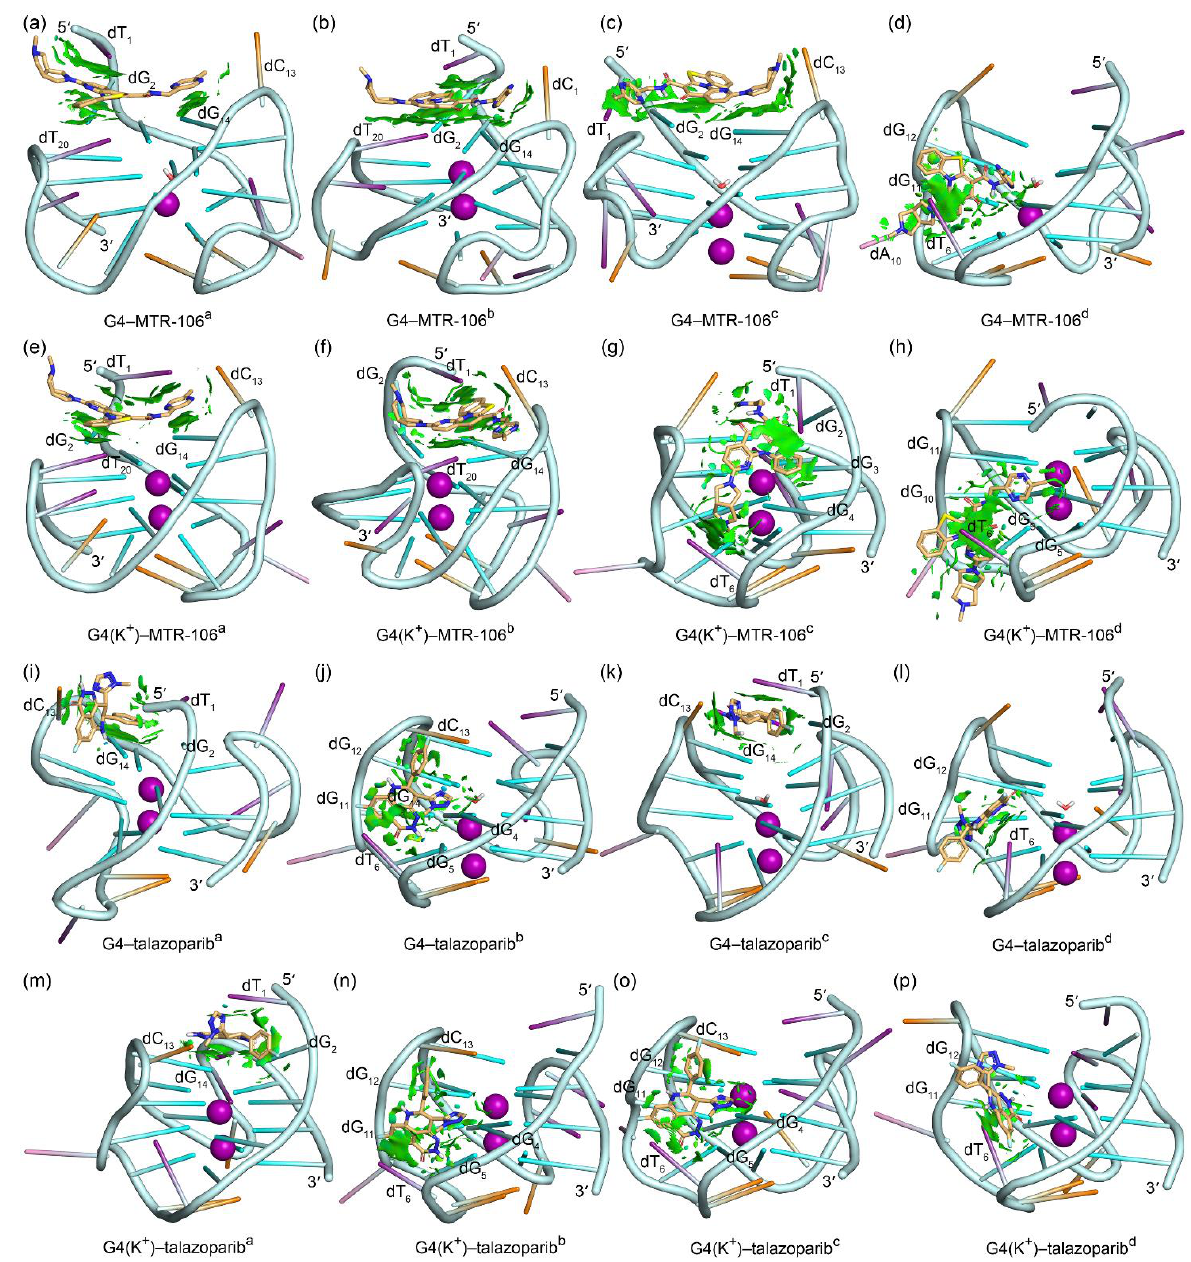
Figure 5. Noncovalent interactions in the MD-equilibrated PARP1 G4/G4(K + )–MTR-106/talazoparib- binding complexes shown as NCI surfaces (isovalue of 0.3 au). The nucleotides involved in the noncovalent interactions are labeled. For clarity, the nucleotide bases of adenine, cytosine, guanine, and thymine are shown as pink, orange, green, and purple sticks, respectively.